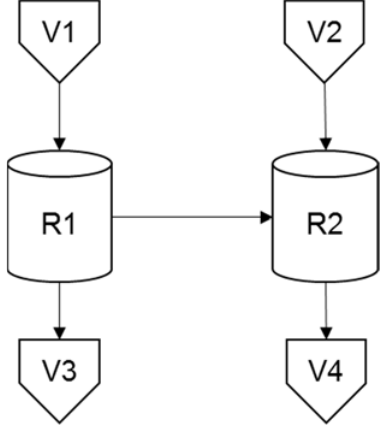
Figure 9. Plant topology for scenario (a).